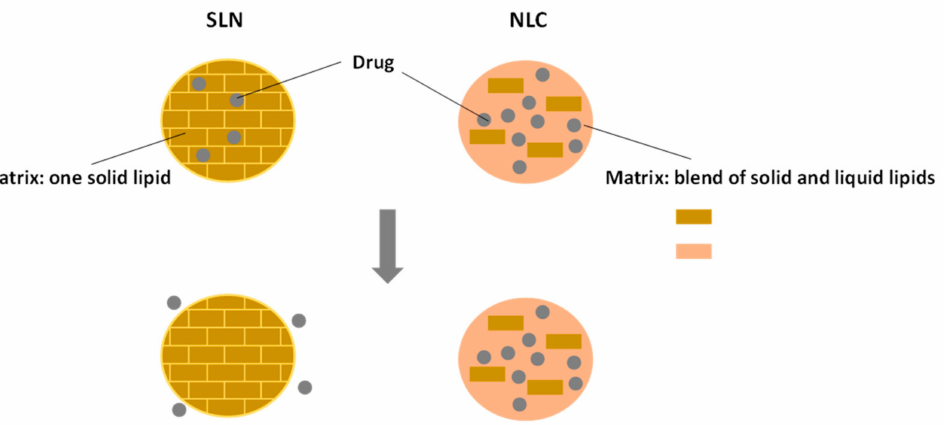
Figure 6. Structure of SLNs and NLCs. Adapted from